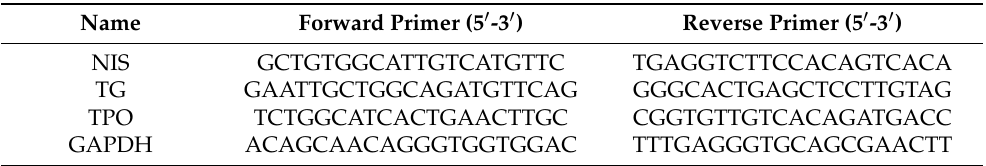
Table 1. Primer sequences used in RT-PCR analysis. The relative mRNA expression levels were normalized using GAPDH mRNA